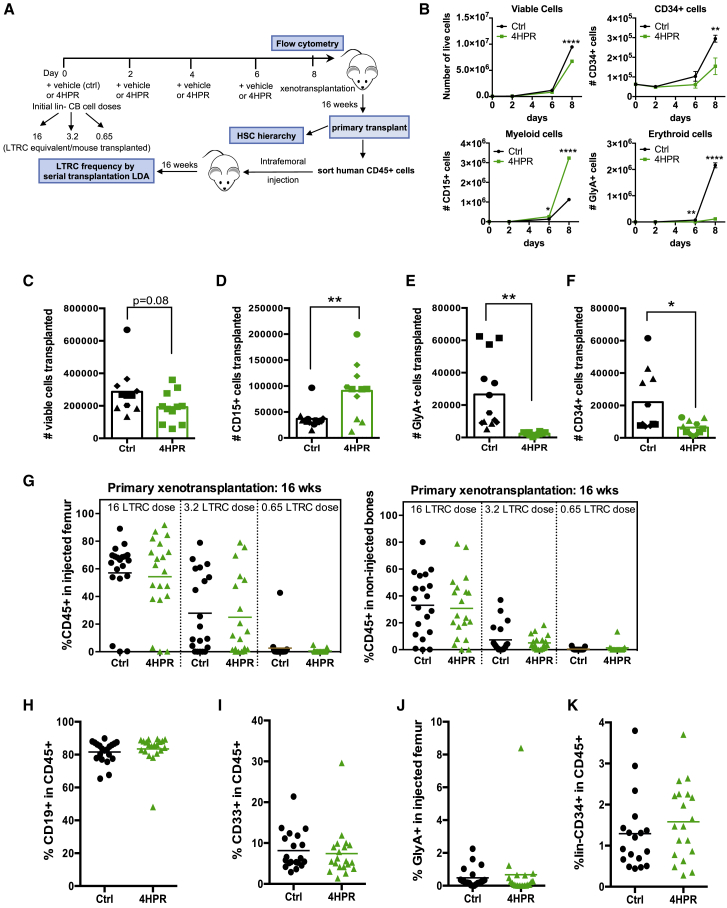
Ex Vivo Treatment with 4HPR Maintains HSC Function following Xenotransplantation(A) Experimental scheme for ex vivo culture of lin− CB followed by xenotransplantation with vehicle control or 4HPR.(B) Total cell counts at 8 days culture for the 16-LTRC dose of a representative experiment (n = 3; CB cultured in triplicate).(C–F) The number of (C) viable cells, (D) CD15+ myeloid cells, (E) GlyA+ erythroid cells, and (F) CD34+ cells injected/mouse were calculated for the 16-LTRC dose by flow cytometry analysis for control or 4HPR treatment prior to xenotransplantation (n = 5 CB pools, 4 in technical triplicate, marked with different symbols).(G) Human CD45+ engraftment at 16 weeks post-transplant in injected femurs and non-injected bones (n = 4 CB pools, 5 mice/drug treatment for each CB pool).(H–K) Lineage analysis of mice engrafted with control or 4HPR-treated cells from Figure 2G for (H) B lymphoid, (I) myeloid, (J) erythroid, and (K) CD34+ lacking CD33 or CD19 markers at the 16-LTRC dose.∗p < 0.05; ∗∗p < 0.01; ∗∗∗p < 0.001.